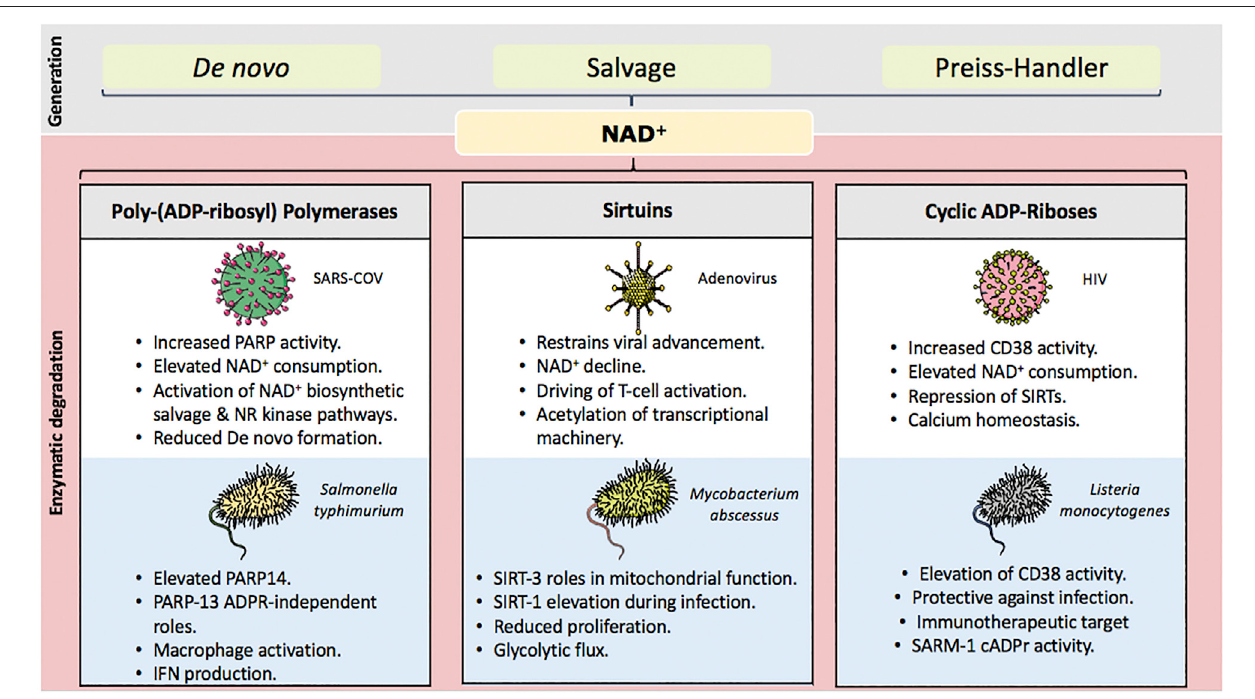
FIGURE 1 | Key NAD + degrading enzyme and their in fl uence over infection. NAD + is generated through three pathways de novo , biosynthetic salvage and their Preiss-handler pathway. NAD + consuming enzymes yield nicotinamide for salvage and conversion back into NAD + . Their activation during infection represents a signi fi cantchallengeforthehostcell.ChronicdeclinesinNAD + concentationsareakeymediatorofbothimmuneandmetabolicdysfunction.Approachestosustainand/ or replete celluar NAD + through precursor supplementation have considerable potential to lessen detrimental outcomes during times of infection.